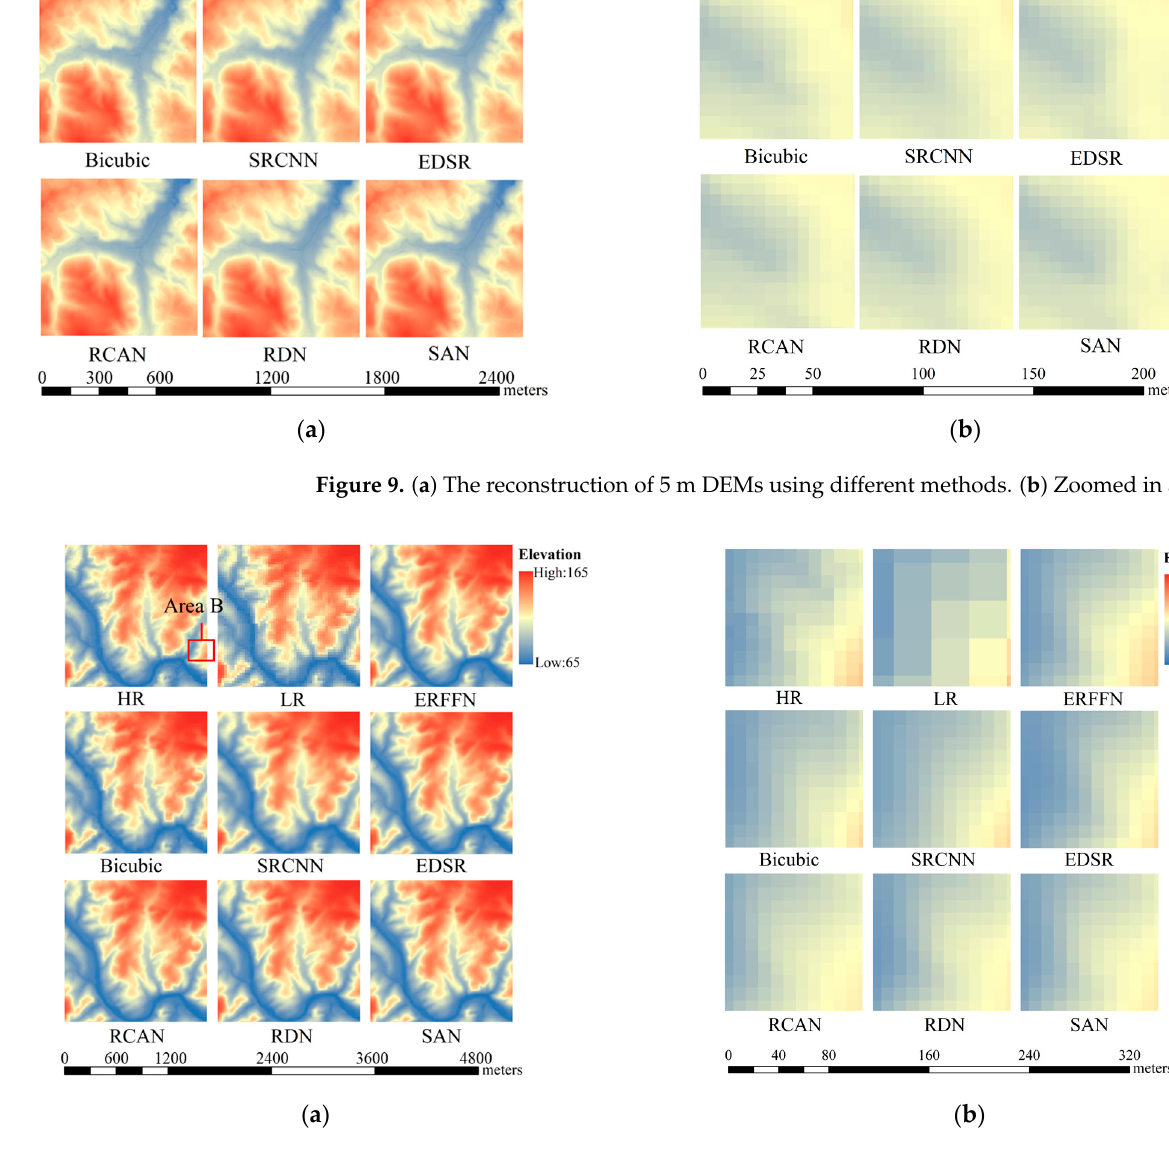
Table 2. Performance evaluation of our method at the reconstruction scale of 2 on the DEM datasets for the Maryland test area.